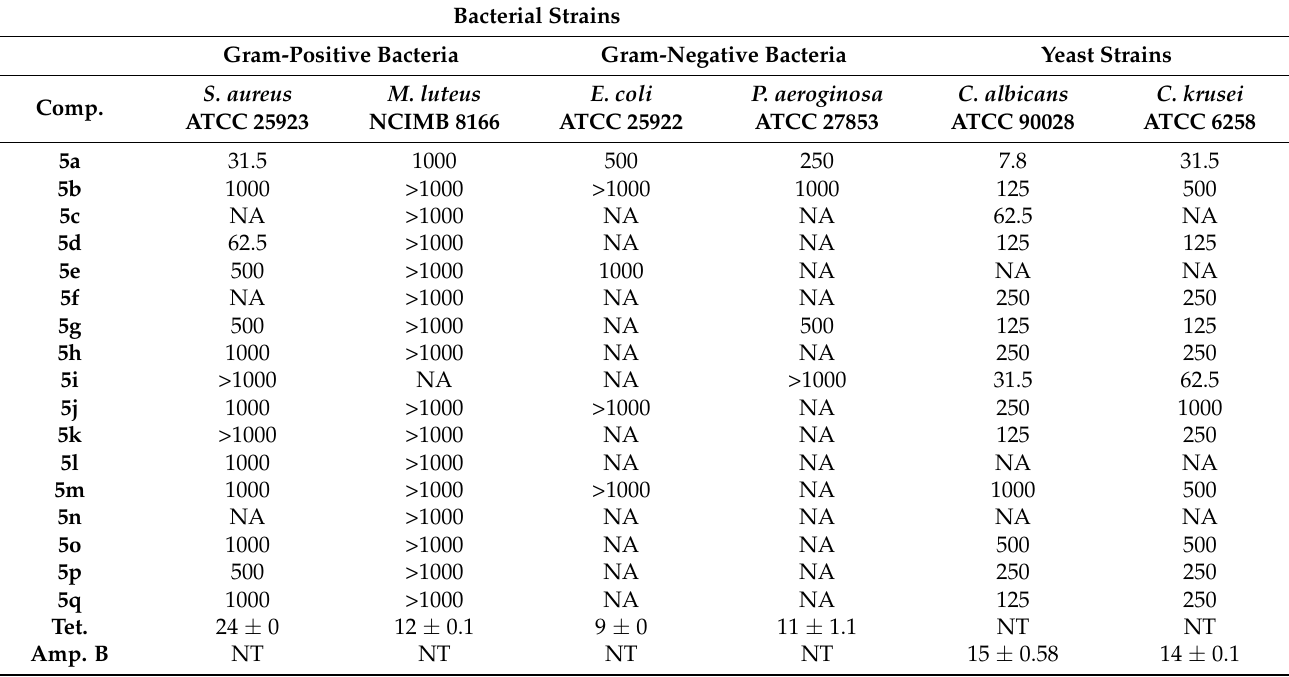
Table 6. Antibacterial and antifungal activity (MBC and MFC in µ g/mL). Bacterial